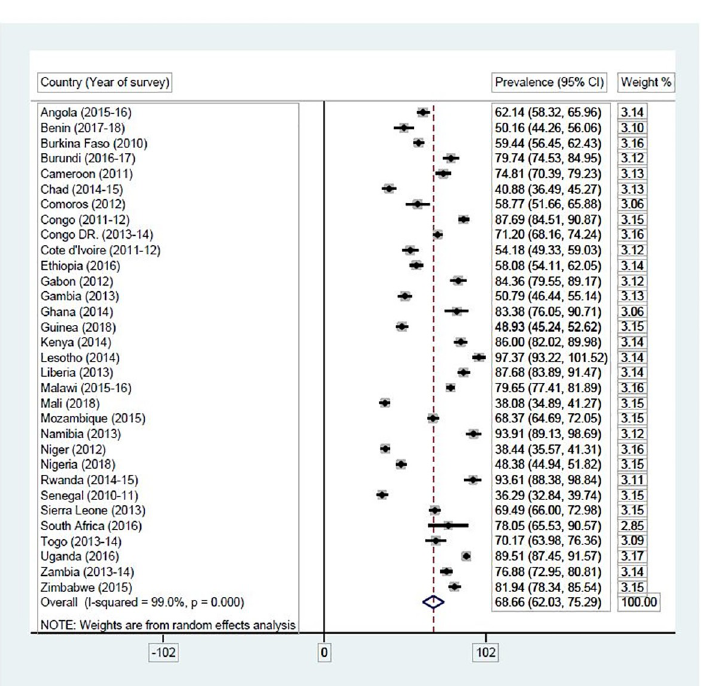
Fig 4. Proportion of female adolescents in SSA who have the capacity to make reproductive health decisions. Source: Authors’ computations.